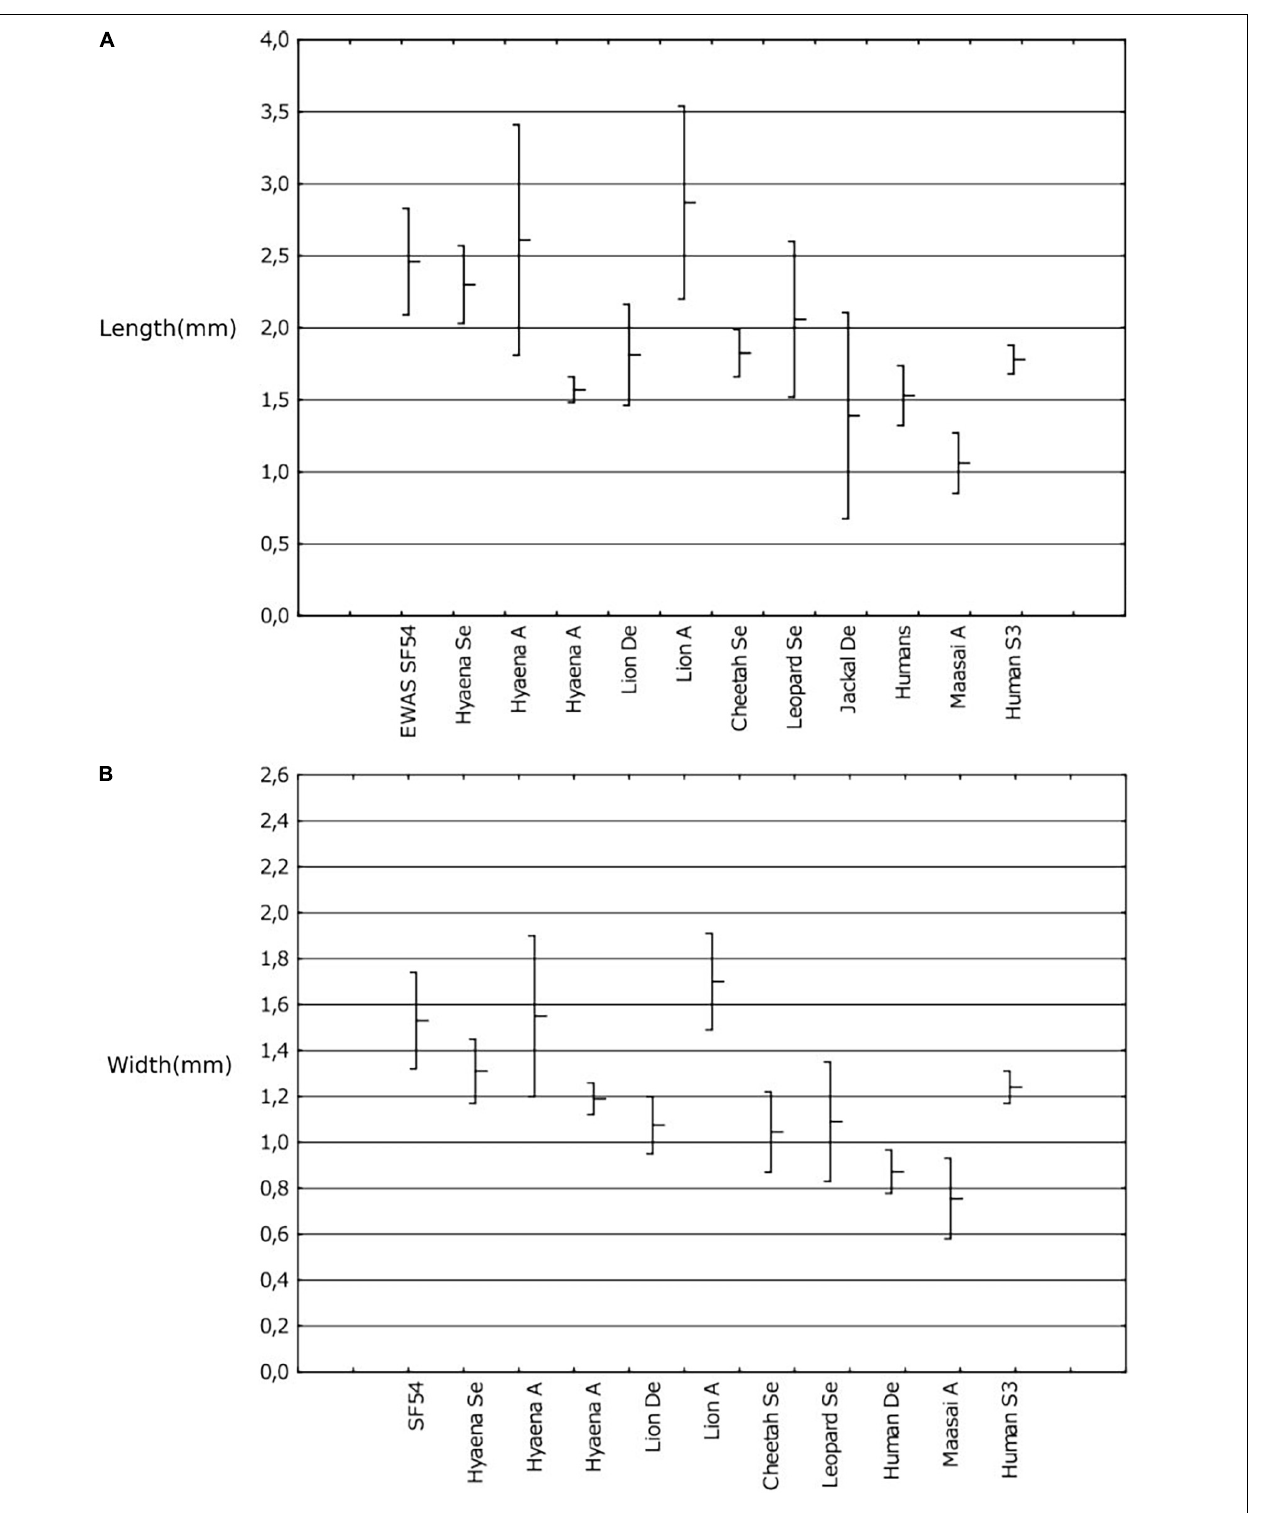
Frontiers in Ecology and Evolution |